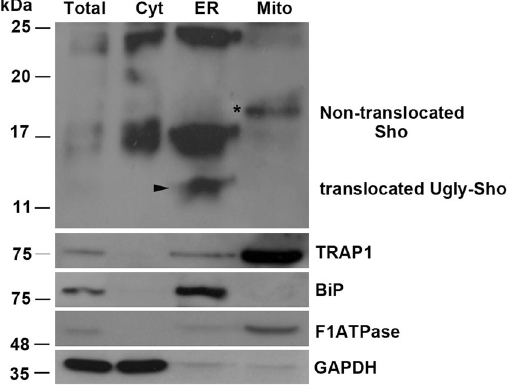
Figure 2. A 18 kDa isoform of Sho is targeted to mitochondria. GT1 cells were processed for mitochondria fractionation assay (see methods for procedure). Total represents the InPut; Cyt: cytosol; ER: microsomal fraction; Mito: mitochondrial fraction. Western blotting with anti- BiP (ER marker), anti-F1ATPase (mitochondrial marker), anti-GAPDH (cytosolic marker) and anti-TRAP1 antibodies were performed as control of the procedure. Note the presence of the 18 kDa Sho isoform only in the mitochondrial fraction (asterisk). At least four independent experiments were